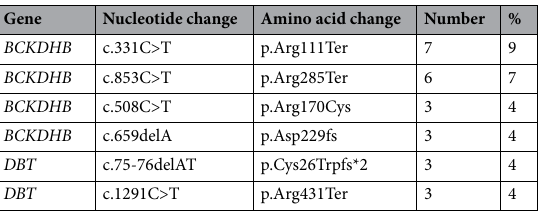
Table 3. Variants with frequency number > 2 in reported Chinese